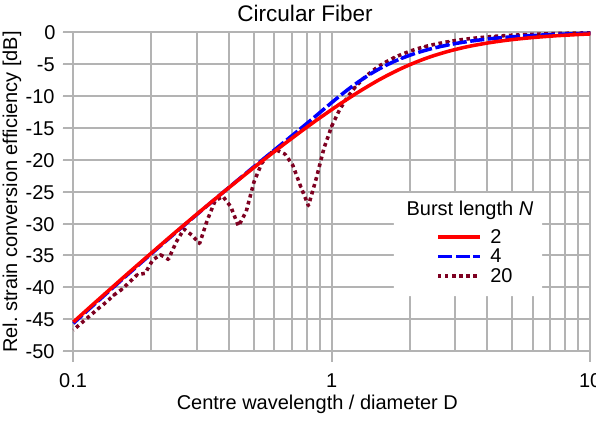
Figure 14. Normalized energy conversion of various sine-burst pulses by a circular fiber segment as a function of λ M / D . The wave strain magnitude is kept